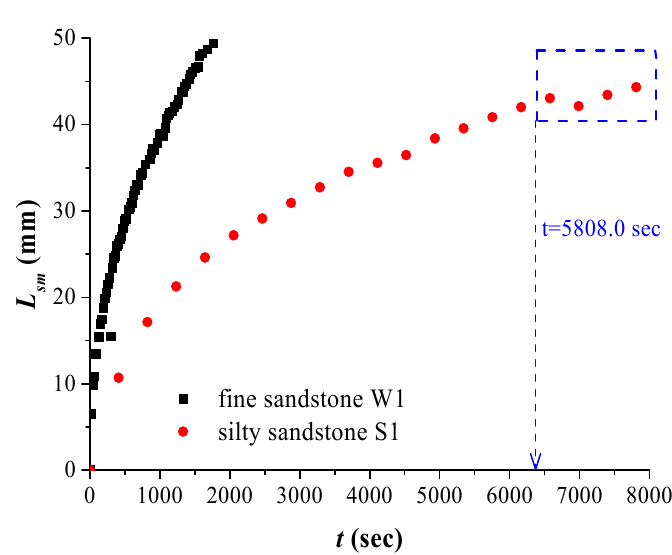
Figure 6. The height of wetting front L sm versus the imbibition time t for two kinds of specimens.